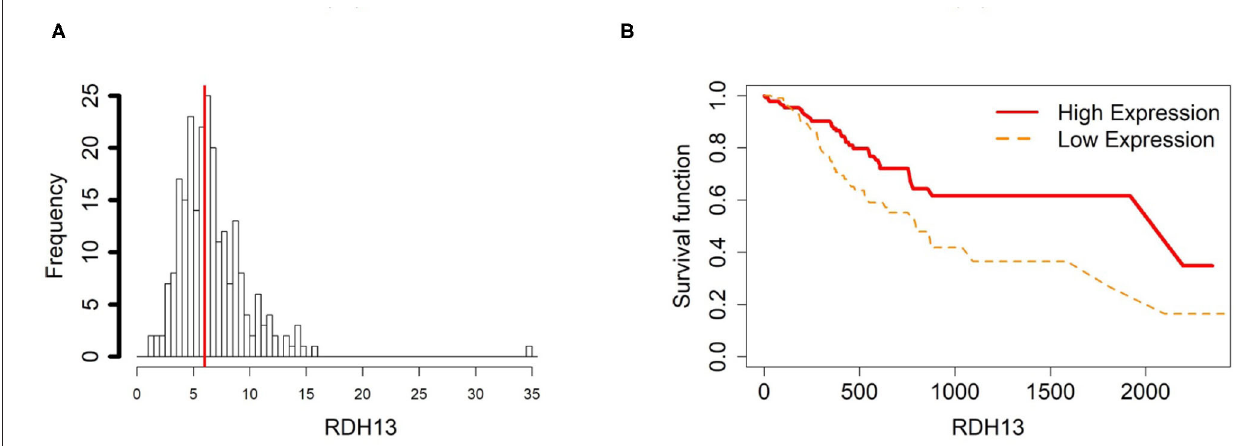
FIGURE 4 | Survival analysis in RDH13. (A) Depicts the histogram of RDH13 gene expression. Based on TCGA-STAD dataset, we set 6 as the gene expression threshold to separate the 238 observations into two groups: low expression and high expression groups of samples. (B) Shows the estimated survival functions using